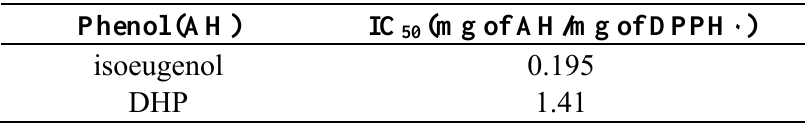
Table 6. Scavenging activity of isoeugenol and DHP toward